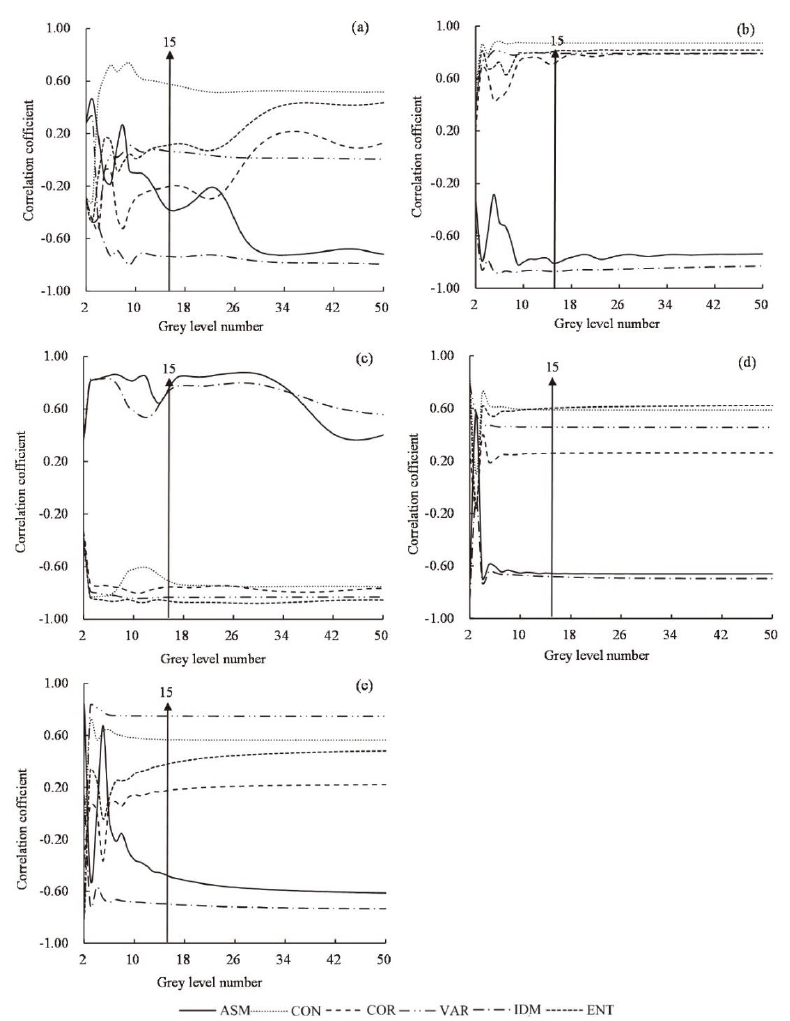
Figure 3. Correlation coe ffi cients for textural parameters and biomass under di ff erent grey level numbers: ( a ) blue band, ( b ) green band, ( c ) red band, ( d ) red-edge band, and ( e ) near infrared